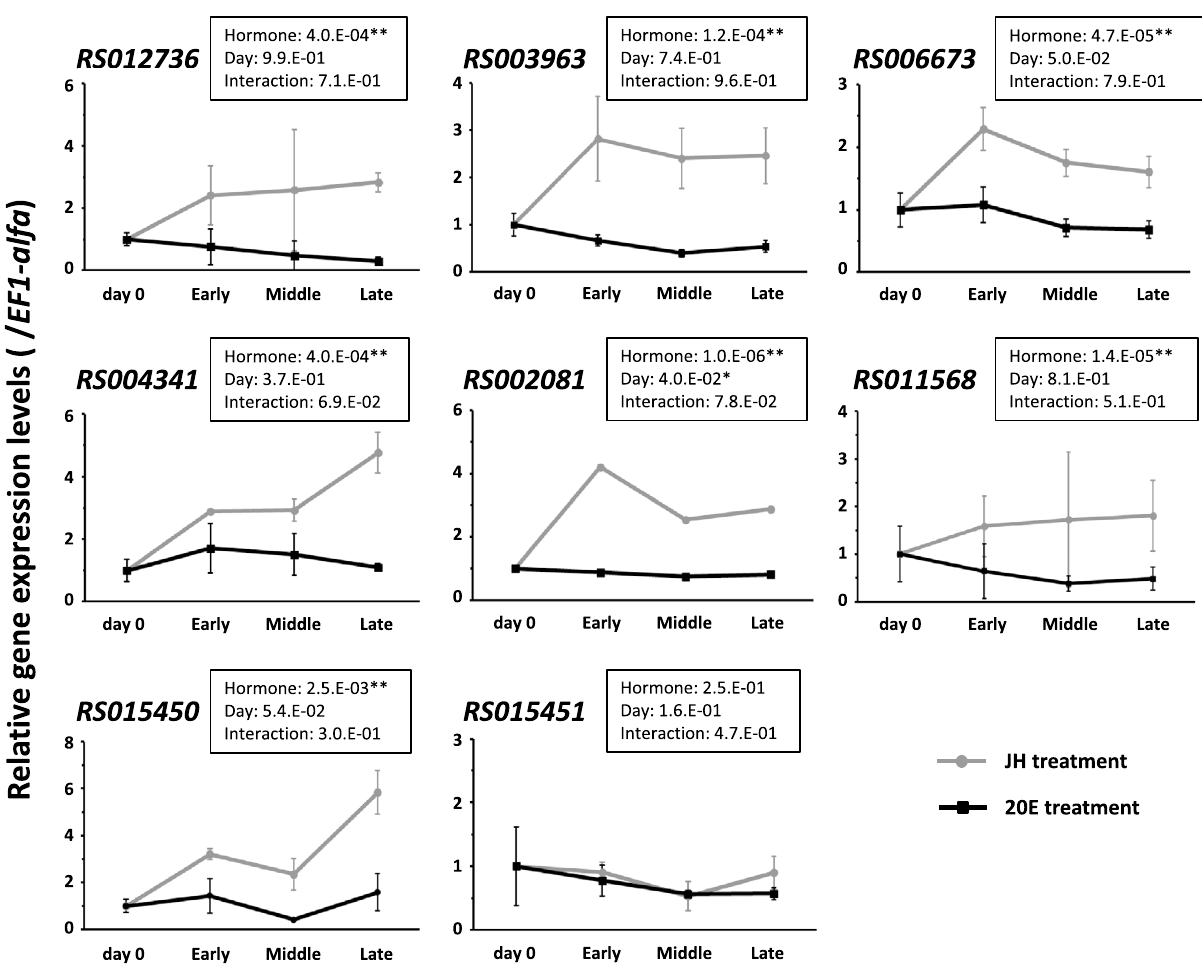
molt (gray line) and worker-worker molt (black line). JH- and 20E-treated individuals collected at three time points [early (day 1–2), middle (day 2–3) and late (day 3–4)] during pre-GP period, and workers in the colony (day 0), were used for the analysis. All data are consistent with the use of parametric statistics by the Levene’s test ( p values are shown in the “Verification of DEGs in worker-presoldier molt” section). Statistical results of two- way ANOVA are described in each box (* p < 0.05, ** p < 0.01). Significant differences among time points were only observed in RS002081 , and no interaction was detected between treatments and time points in all